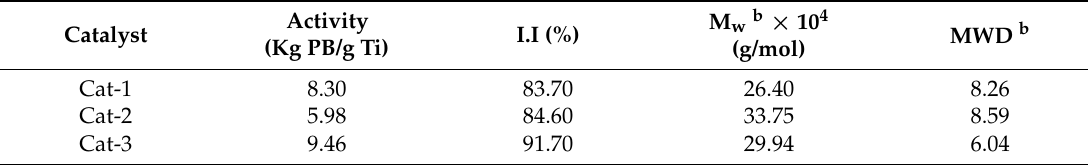
Table 2. The effect of IED on 1-butene slurry polymerization a .